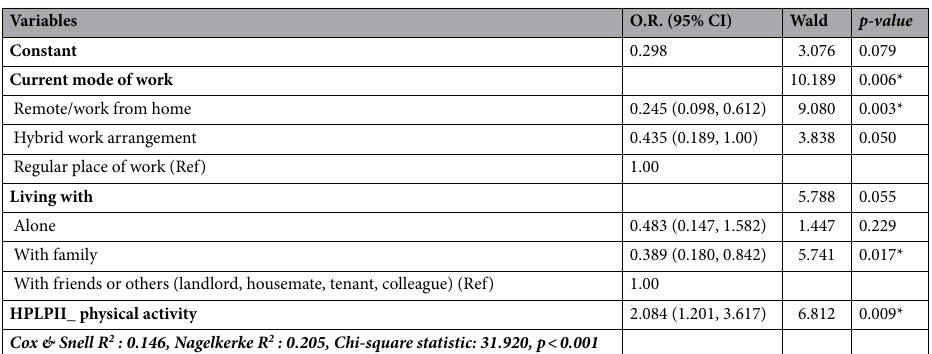
Table 5. Predictors of determinants of a high level of PA in the final